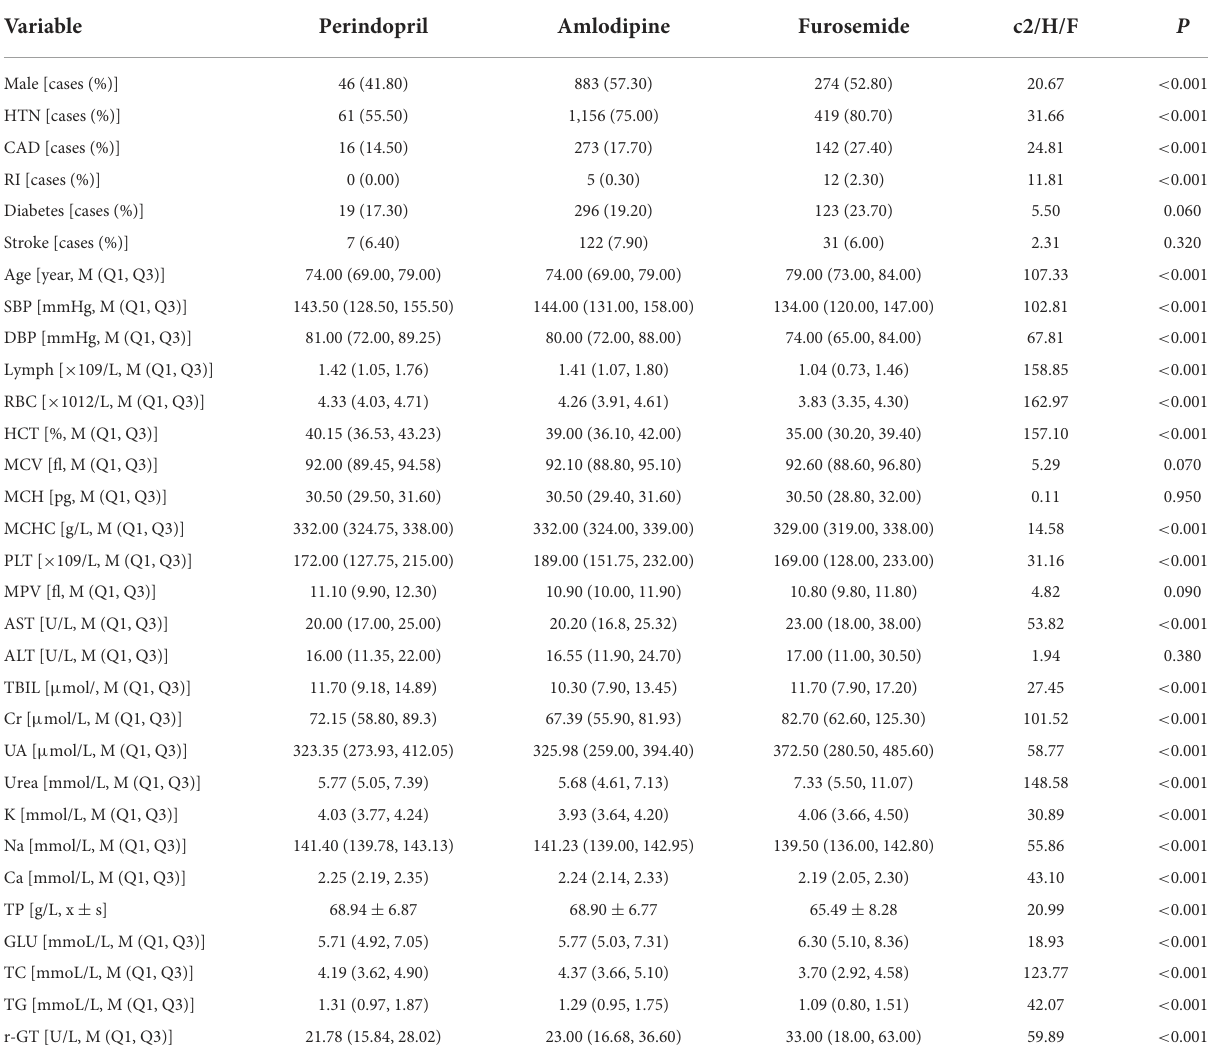
TABLE 1 Test the difference in the indexes in patients using different kinds of drugs. Variable Perindopril Amlodipine